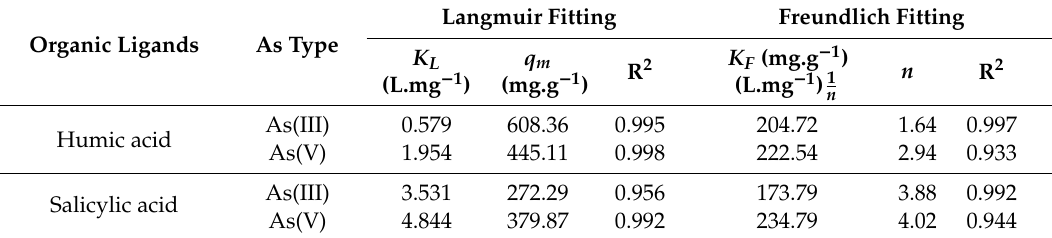
Figure 4. Adsorption isotherm of As adsorption onto precipitated Fe in ( A , B ) As(III); and ( C , D ) As(V) system in the presence of 10 mgL − 1 organic ligands under varying initial As concentration (0–10 mgL − 1 ) at pH 7.0 ± 0.1. Table 1. Adsorption isotherm fitting parameters of As(III, V) species onto Fe precipitates in the presence of various organic